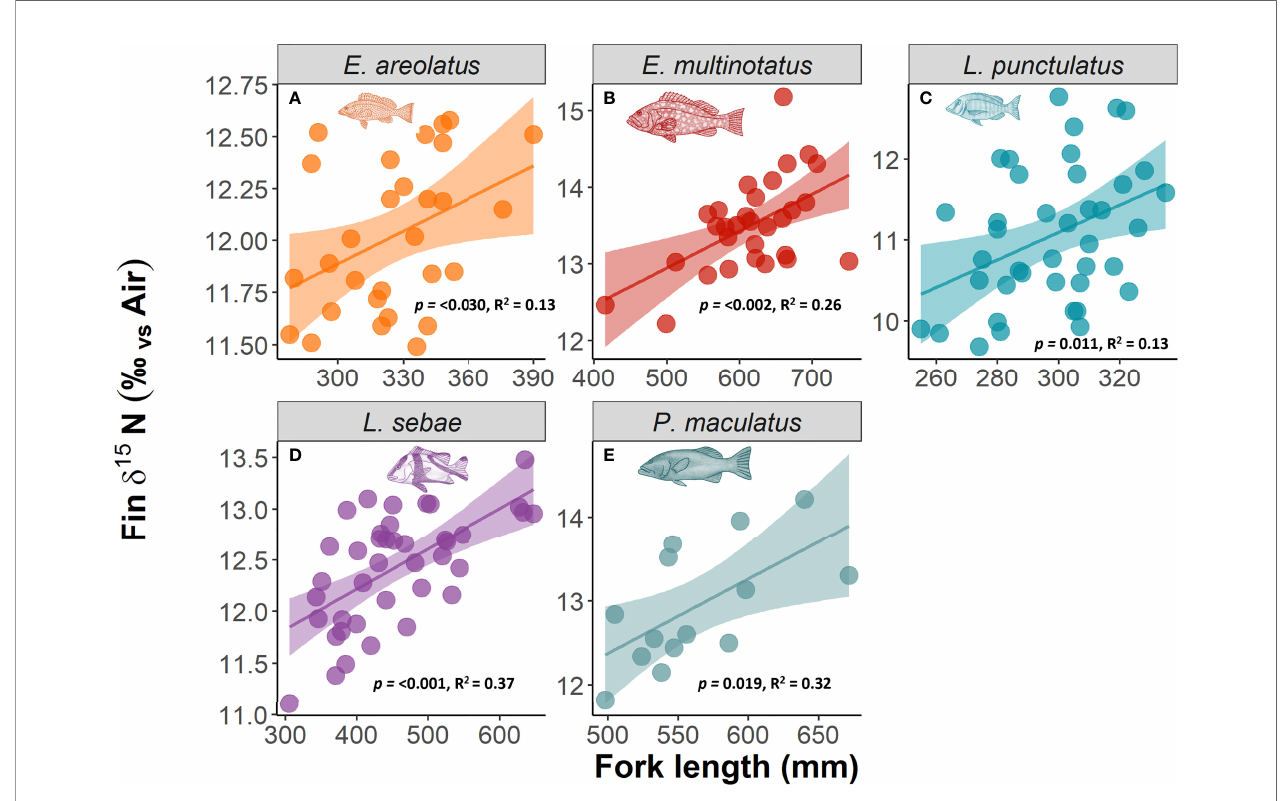
FIGURE 5 | The relationship between d 15 N and body length of fi sh. Signi fi cant relationships in bold